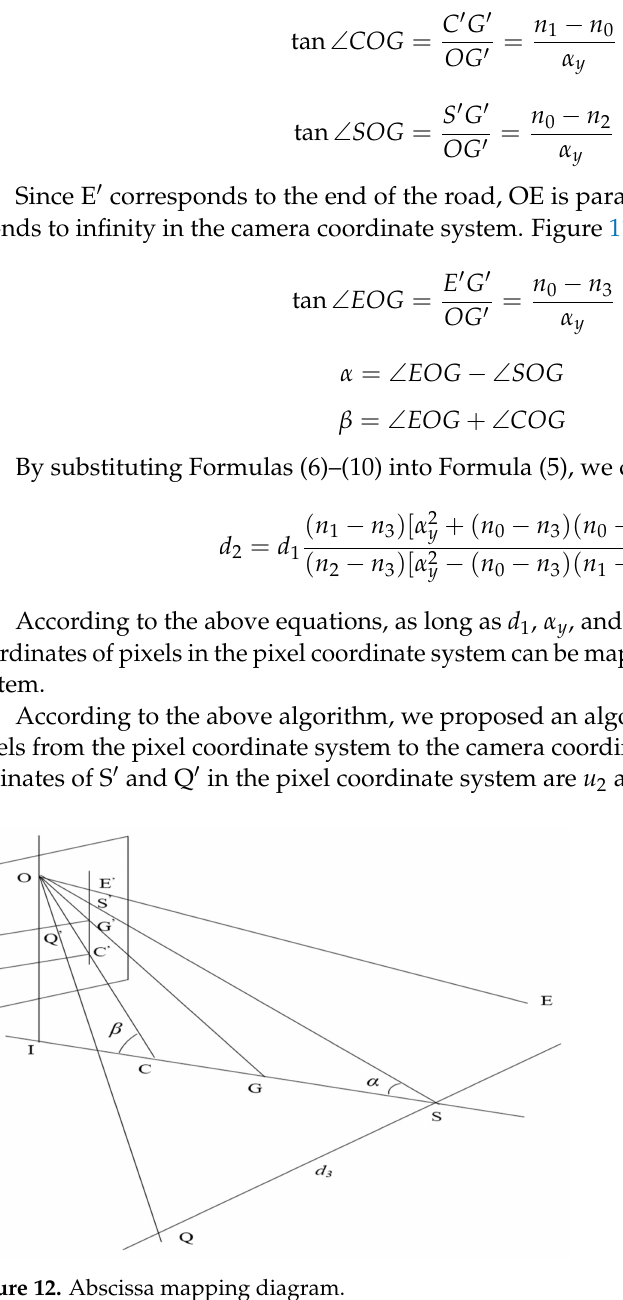
Figure 12. Abscissa mapping